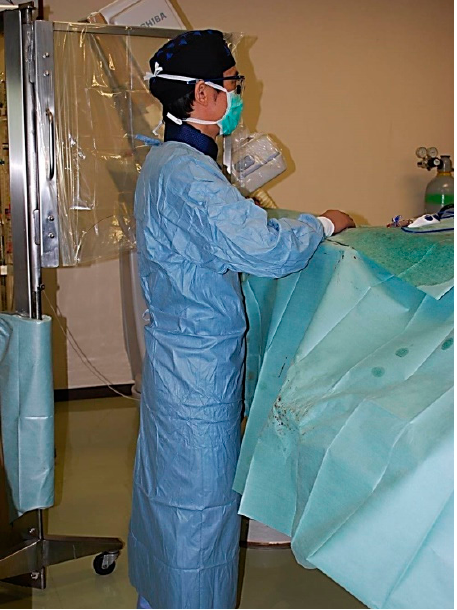
Figure 2. Photograph during the cardiac catheterization procedure.